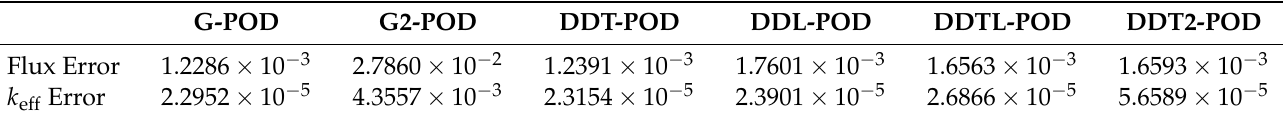
Figure 10. Boxplots showing the errors for all six methods. The median is given by the orange line, the interquartile ranges by the box and the minimum and maximum values by whiskers. Table 4. Mean absolute maximum errors in the flux profile and k eff for solutions using POD-based reduced-order